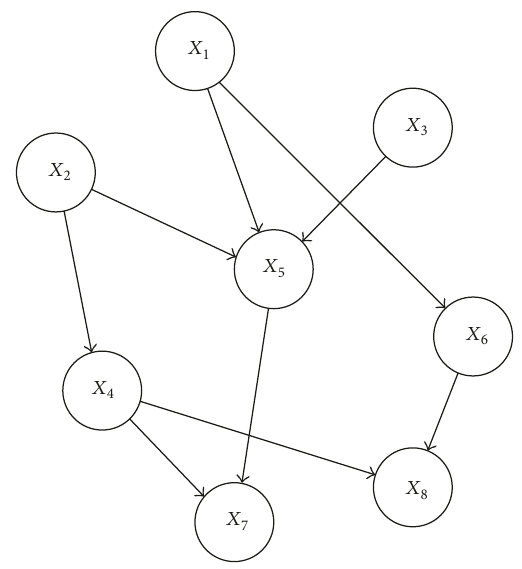
structure which denotes the conditional independent asser- tion in variable set 𝑋 , 𝑃 is a set of local probability distribu- tions associated with each variable, 𝑋 𝑖 denotes the variable node, and 𝑝𝑎 𝑖 denotes the father node of 𝑋 𝑖 in 𝑆 . 𝑆 and 𝑃 define the joint probability distribution of 𝑋 . 𝑆 is a directed acyclic graph (DAG), and each node in 𝑆 corresponds to a variable in 𝑋 (Figure 1). The default arc between nodes of 𝑆 denotes conditional